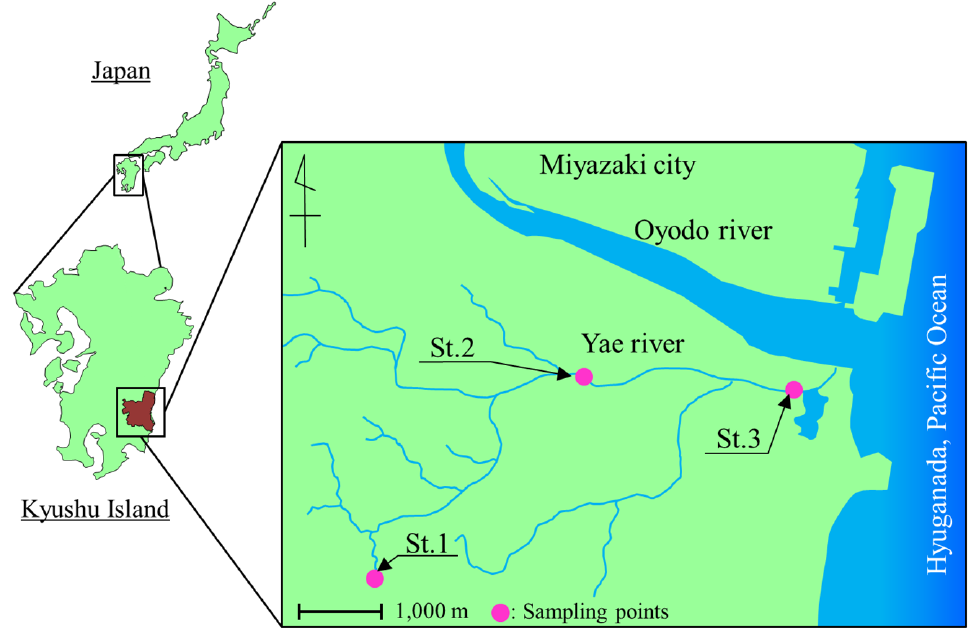
Figure 1. The locations of sampling points in Yae River in Miyazaki city, Japan. St.1: upstream, St.2: midstream, and St.3: downstream.